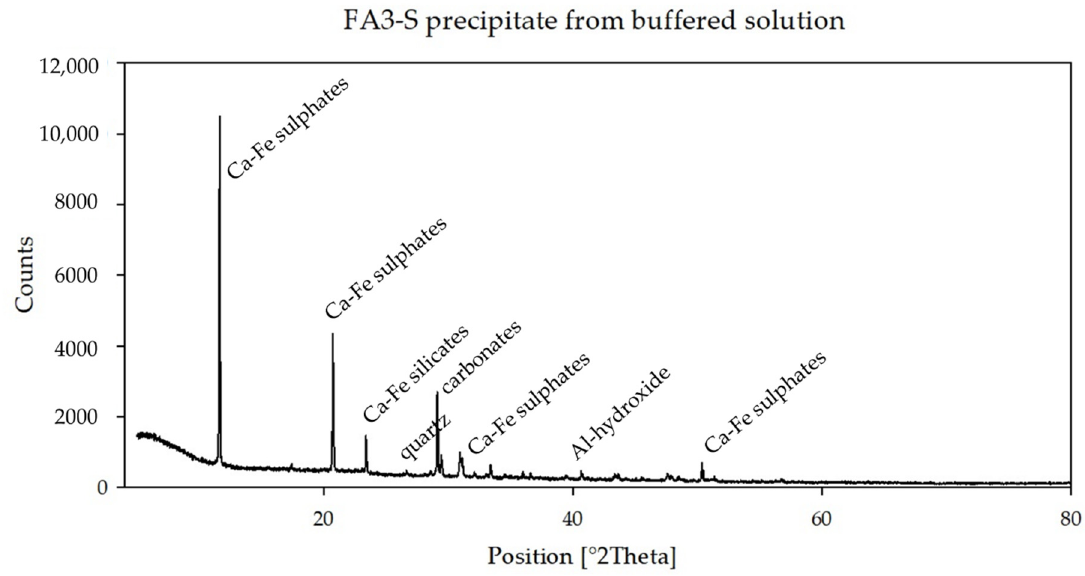
Figure 3. XRPD pattern of FA3-S precipitates and qualitative analyses for content of mineral phases.